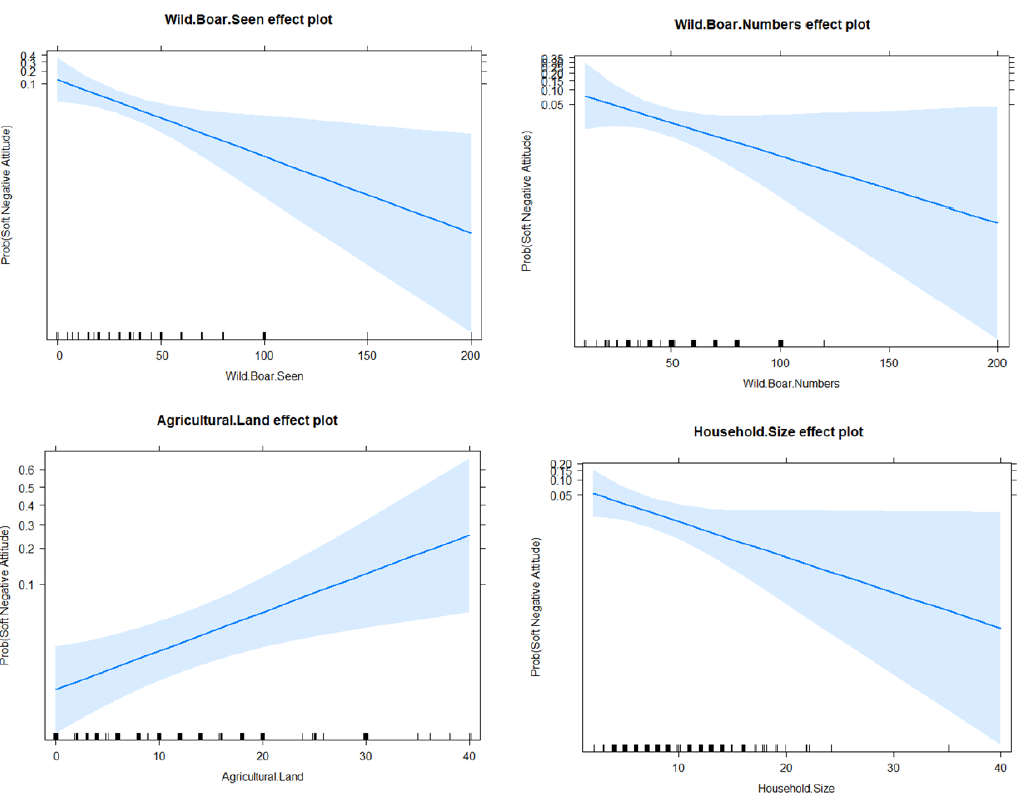
Figure 4. The probability of the appearances of soft negative attitudes for each influential factor, for each level, over the chances of the respondents’ having positive attitudes towards wild boars.